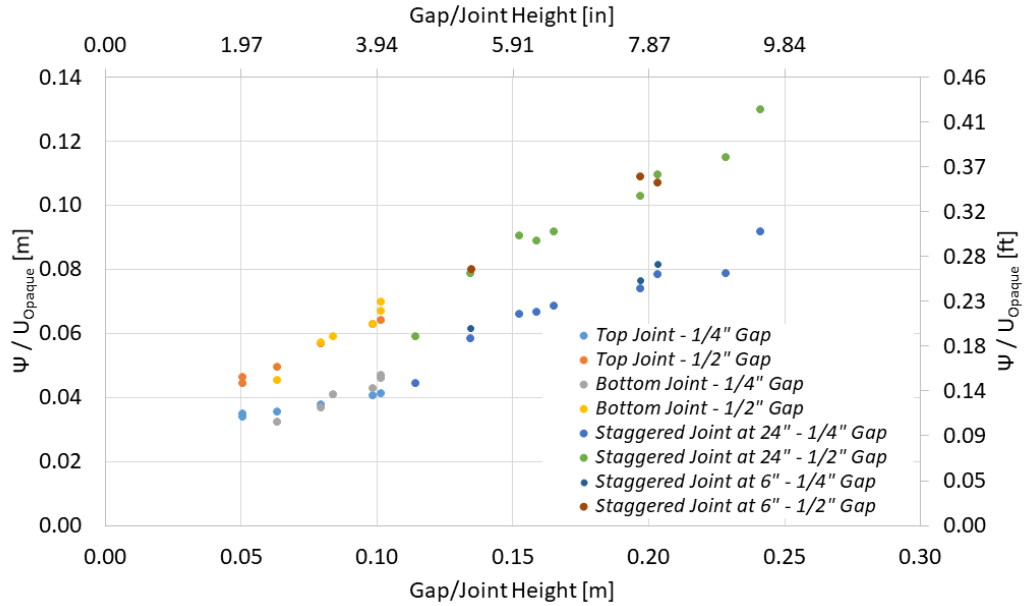
Ψ /U /U opaque as a function of the Height of the Joint for all Joint Configurations. Figure 10. Change in Figure 10. Change in opaque as a function of the Height of the Joint for all Joint Configurations. To further normalize the results and determine the Psi factor for the joint gaps, the Ψ relationship in Equation (6) was applied to the results and graphed in Figure 11.